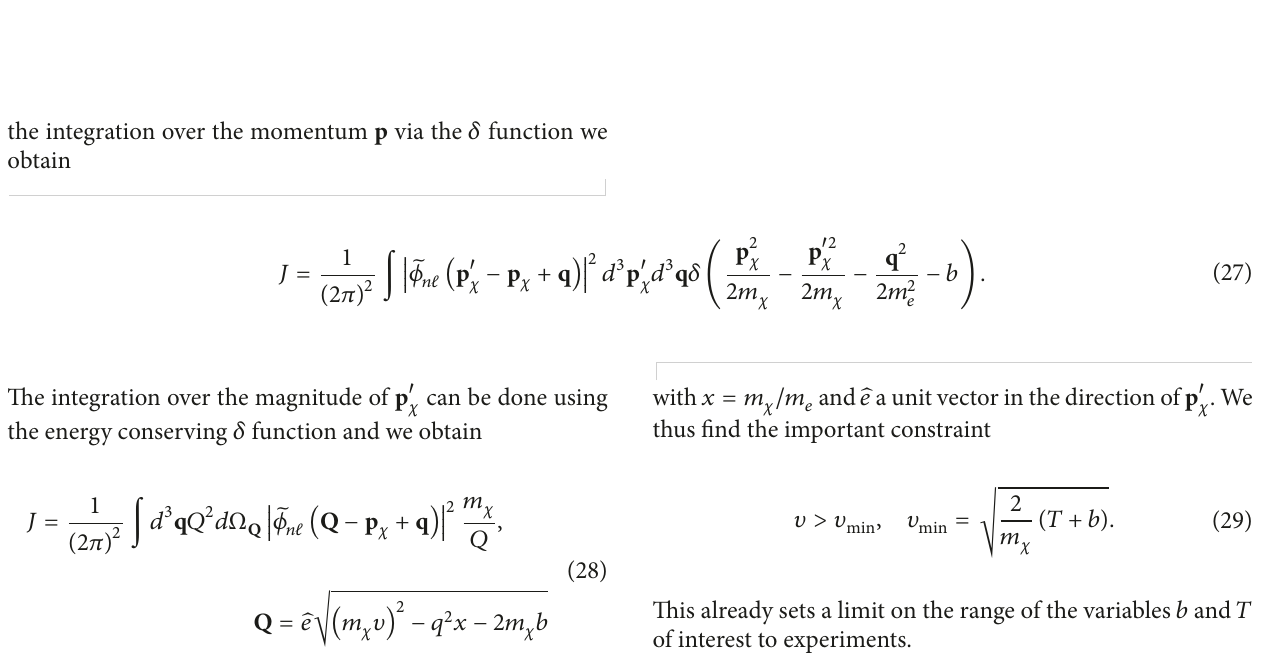
Figure 3: The total average WIMP-electron cross section in units 𝜎 0 as a function of the WIMP mass in units of the electron mass. In panel (a) the Fermi function was neglected, while in panels (b) and (c) the Fermi function 𝐹 for 𝑛 = 3 and 𝑍 = 50 and 𝑛 = 4 and 𝑍 = 60 , respectively, has been